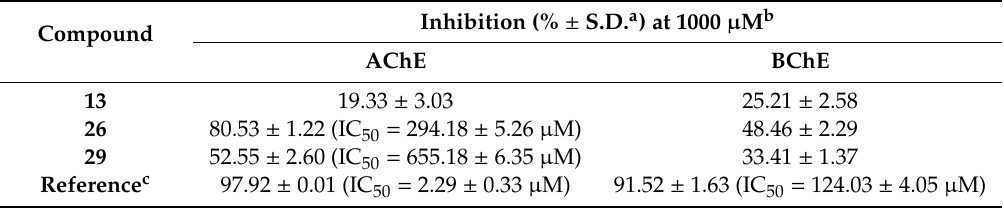
Table 5. Inhibition (% ± S.D.) and IC 50 values of compounds 13 , 26 , and 29 screened against acetylcholinesterase (AChE) and butyrylcholinesterase (BChE).